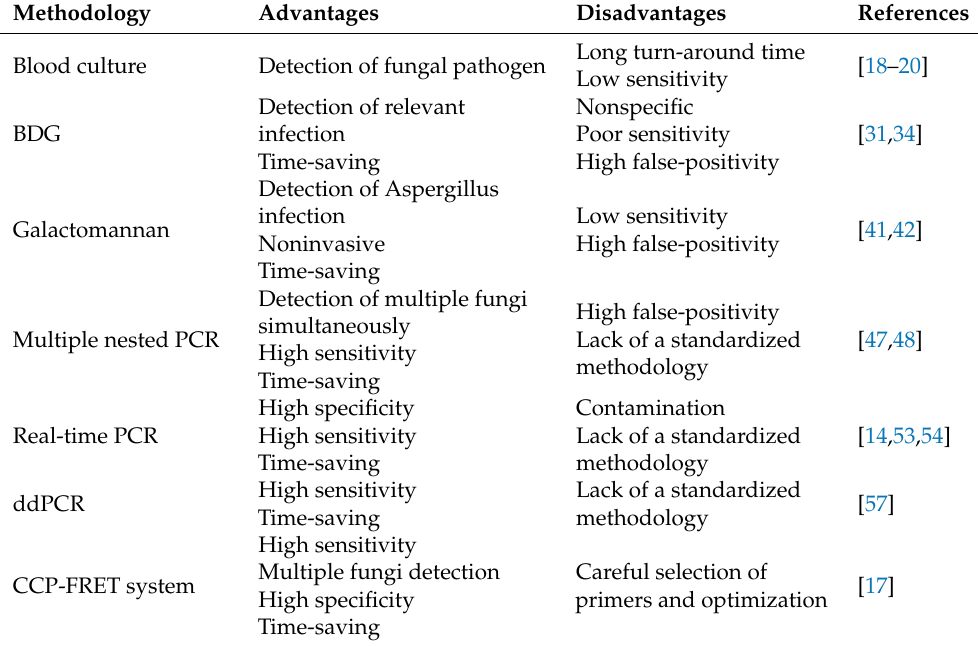
Table 1. Overview of the Laboratory Identification of Invasive Fungal Infection in Neonates.